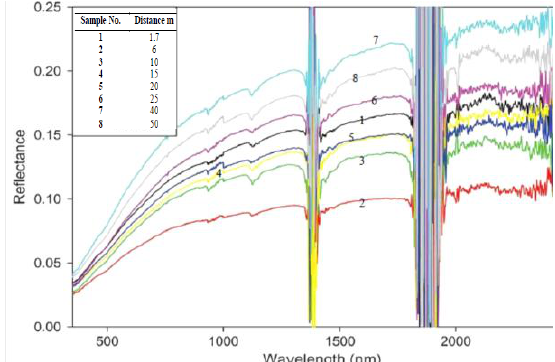
Figure 2. An illustration (Pandit et al. 2010) of the inverse relationship between the wavelength and soil Pb content for eight soil samples from a transect of near-road to far-road. Also, shown are the noise regions at 1400 and 1900 nm due to the influence of atmospheric water at outdoor reflectance measurement (Cocks et al., 1998; Pandit et al., 2010). Distances of the samples from the road are given in the